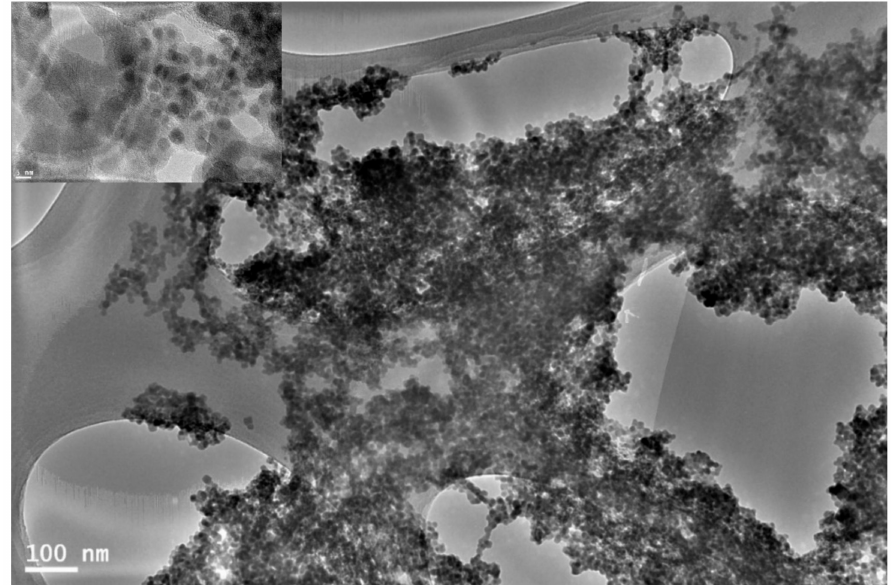
Figure 1. TEM image of CsPbBr 3 perovskite quantum dots (PQDs). The inset is TEM image with scale bar of 5